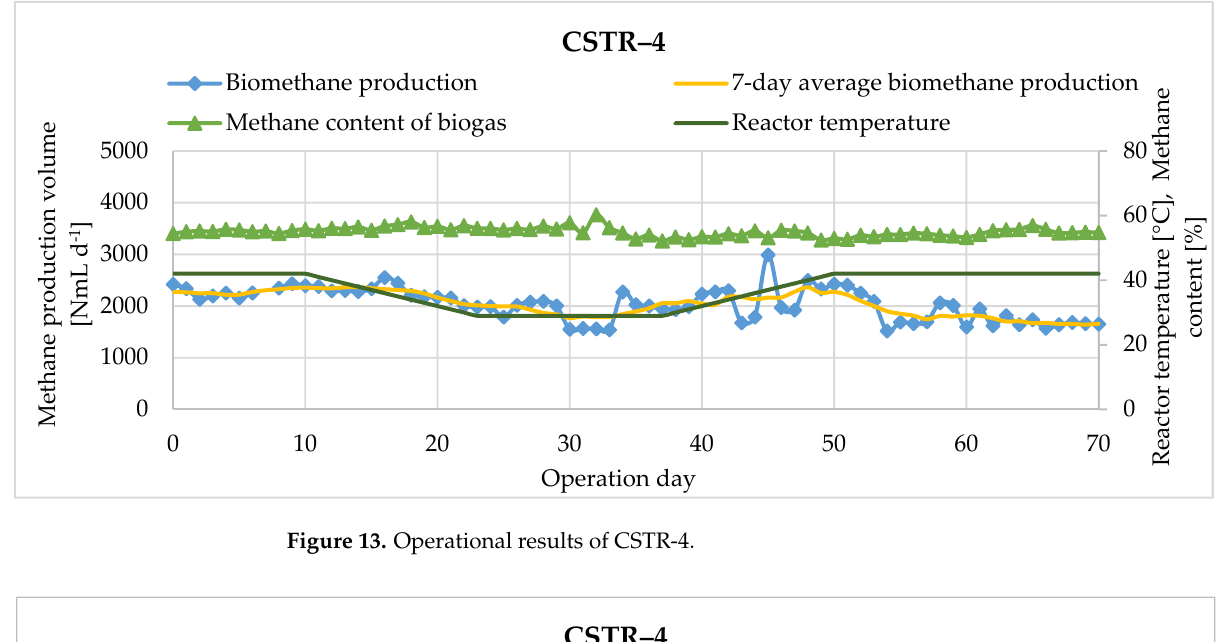
Figure 13. Operational results of CSTR-4.